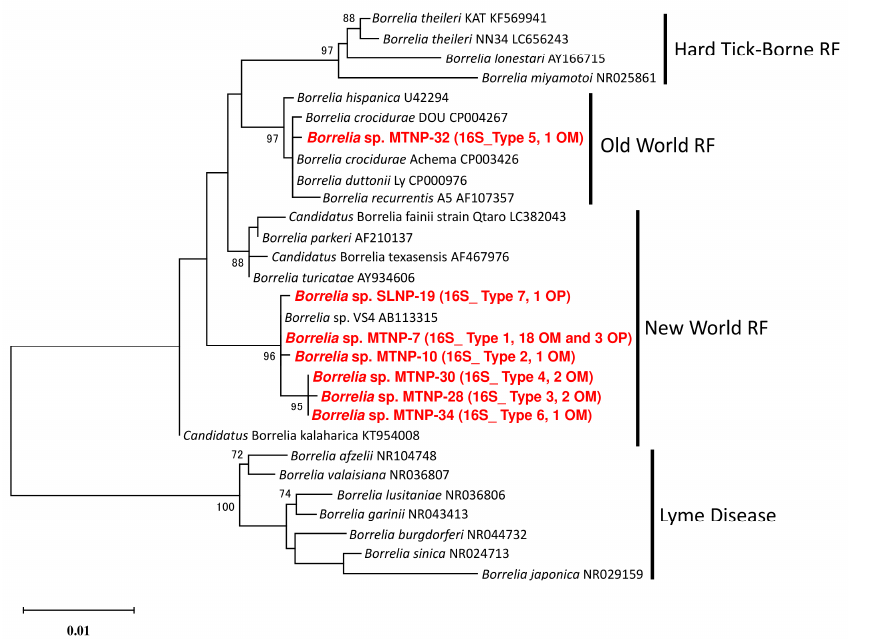
Figure 3. Phylogenetic tree of the Borrelia spp. based on 1355 bp of 16S ribosomal DNA sequences. The analyses were performed by the ML method with the Kimura-2 parameter. The sequences generated herein are displayed in bold and red font. The 16S rDNA sequence types and the numbers of samples with the same sequence are enclosed in brackets. OM and OP refer to Ornithodoros moubata and O. porcinus , respectively. Bootstrap values > 70% are based on 1000 replications and are shown beside the branches.